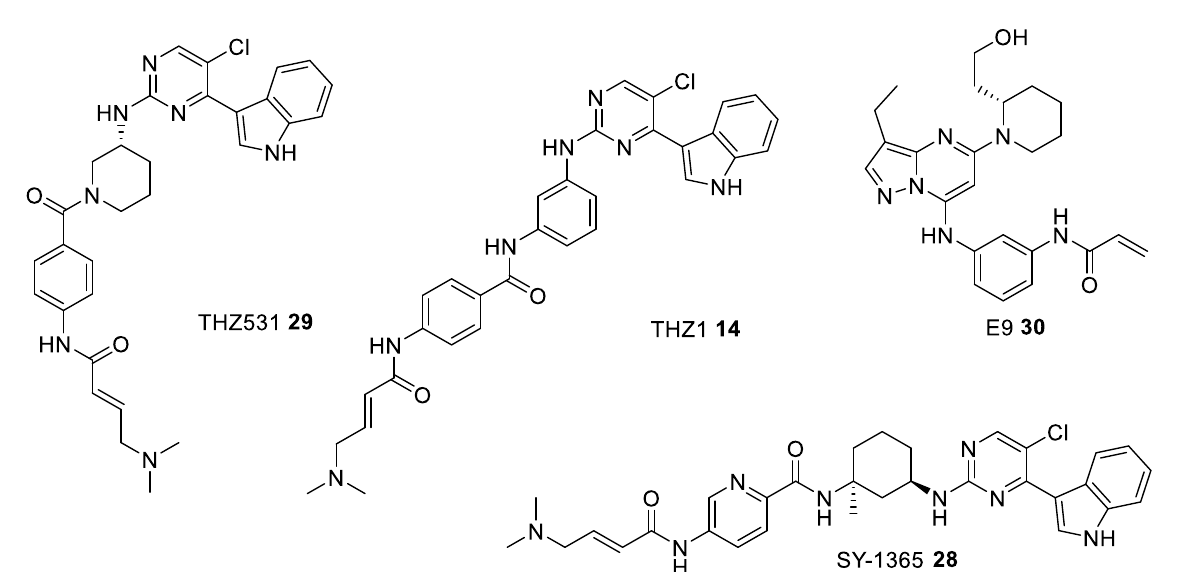
Figure 7. Chemical structures of some of the most studied type VI CDK inhibitors.